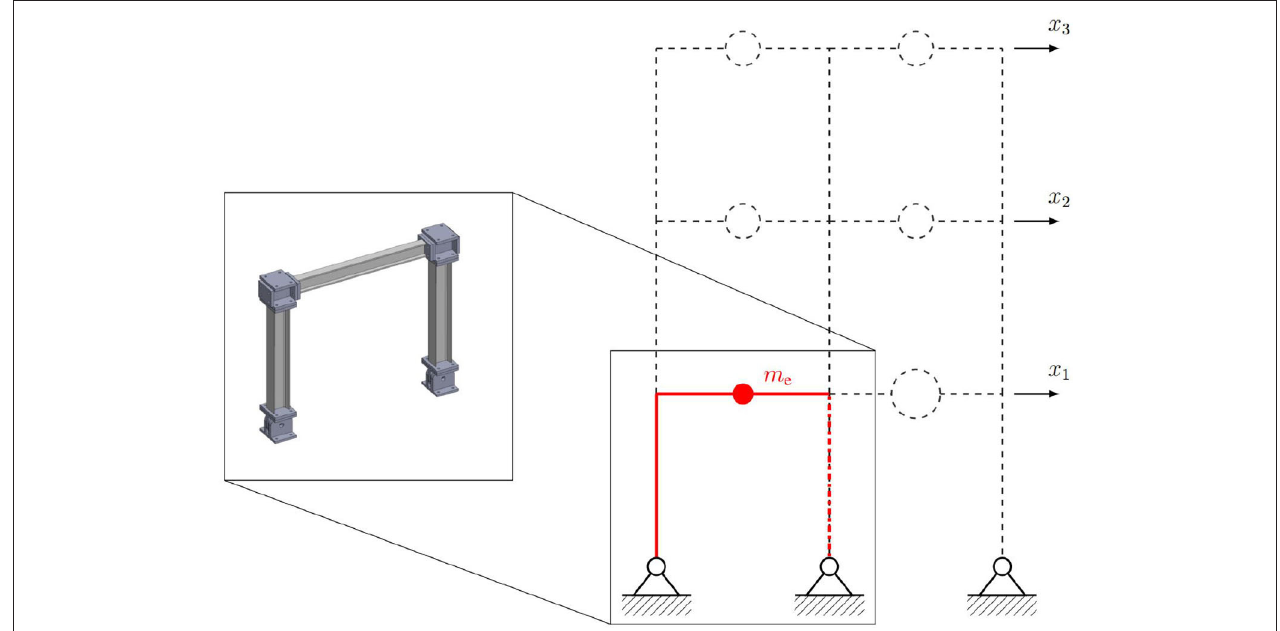
FIGURE 9 | Numerical and experimental substructures of benchmark structure by Silva et al. (2020).